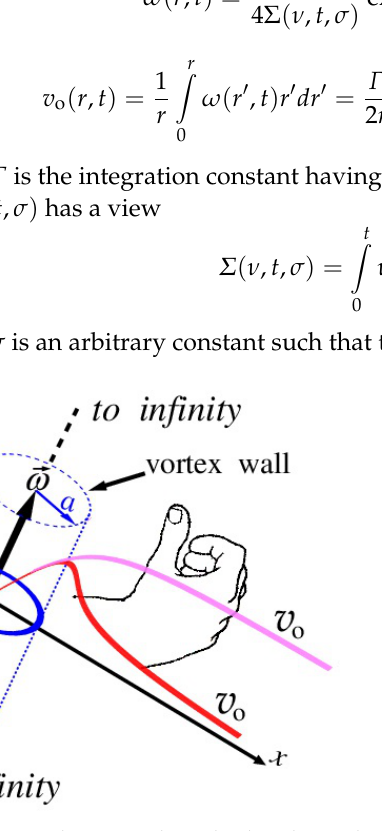
Figure 2. Vortex shown in the cylindrical coordinate system extends from minus infinity to plus infinity. The vortex wall is a boundary, where the orbital speed, v o , reaches maximal values; a is the radius of the vortex tube, (cid:126) ω is the vorticity. Profiles of the orbital velocity (cid:126) v o at different N in Equation (25): ( a ) N = 1, normal profile; ( b ) N (cid:29) 1, nondecreasing profile with